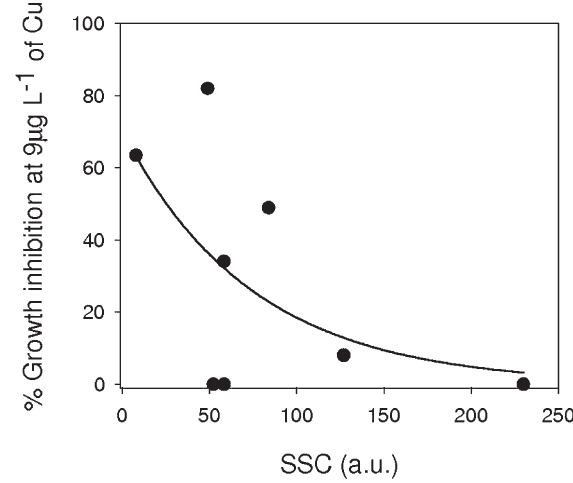
Fig . 9. – Scatter plot of size relationship with microalgae copper tolerance, expressed as the different % of growth inhibition at the copper exposure concentration of 9 µg L -1